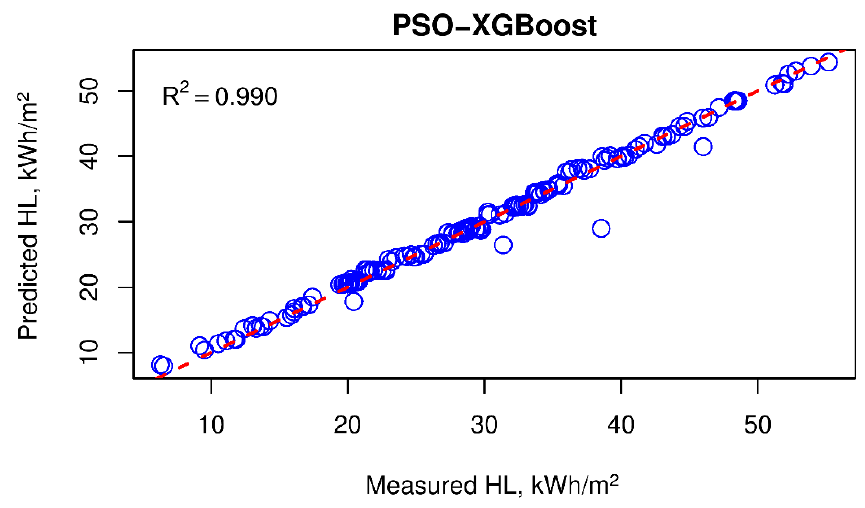
Figure 11. The results of HL prediction from the proposed PSO-XGBoost model. Compared with the classical XGBoost model (without being optimized by the PSO algorithm),